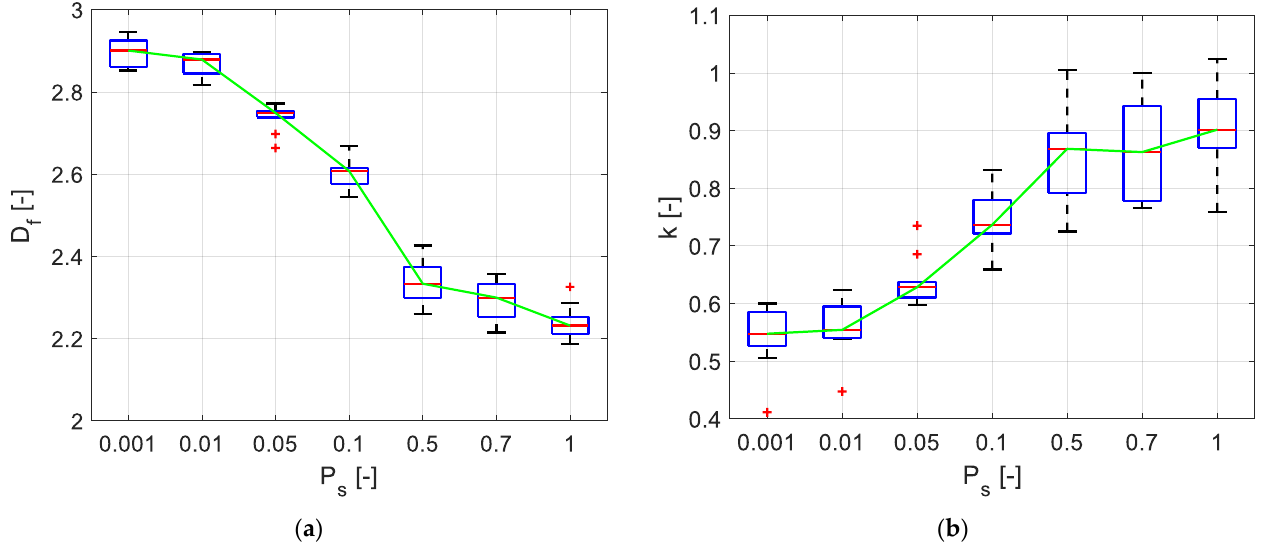
Figure 2. The fractal dimension ( a ) and prefactor ( b ) of agglomerates constructed by employing the sticking probability model at different sticking probabilities ( P s ).